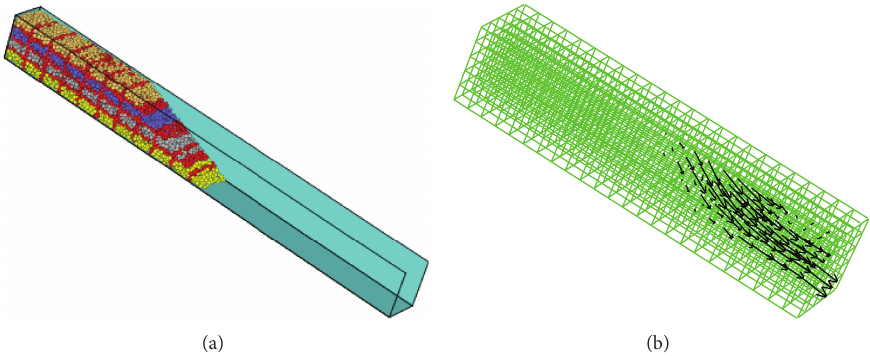
Figure 9: The numerical model (PFC 3 D ) and fluid grid cell of debris flow numerical model.